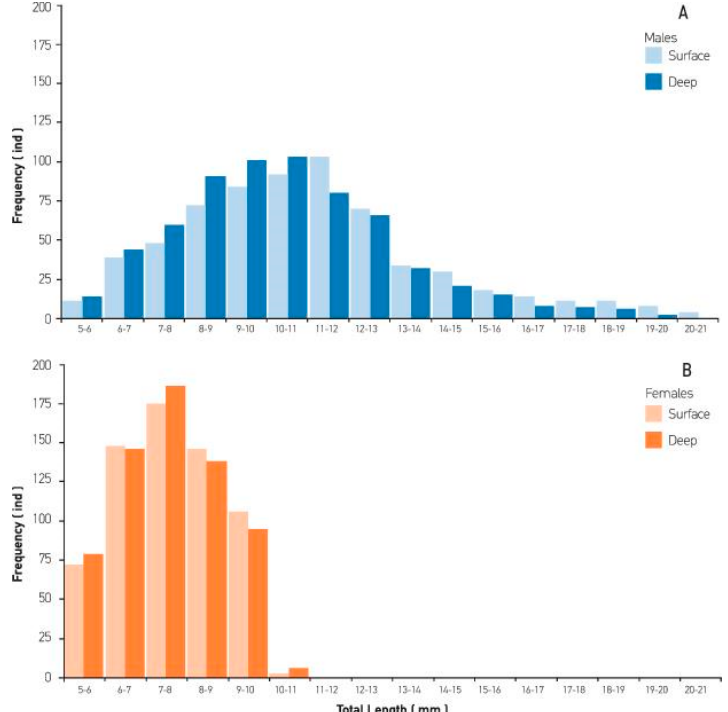
Figure 7. Length–frequency distributions of ( A ). Male and ( B ). Female individuals from the Surface and Deep populations of Caprella scaura, from a fish farm in the Pagasitikos Gulf.